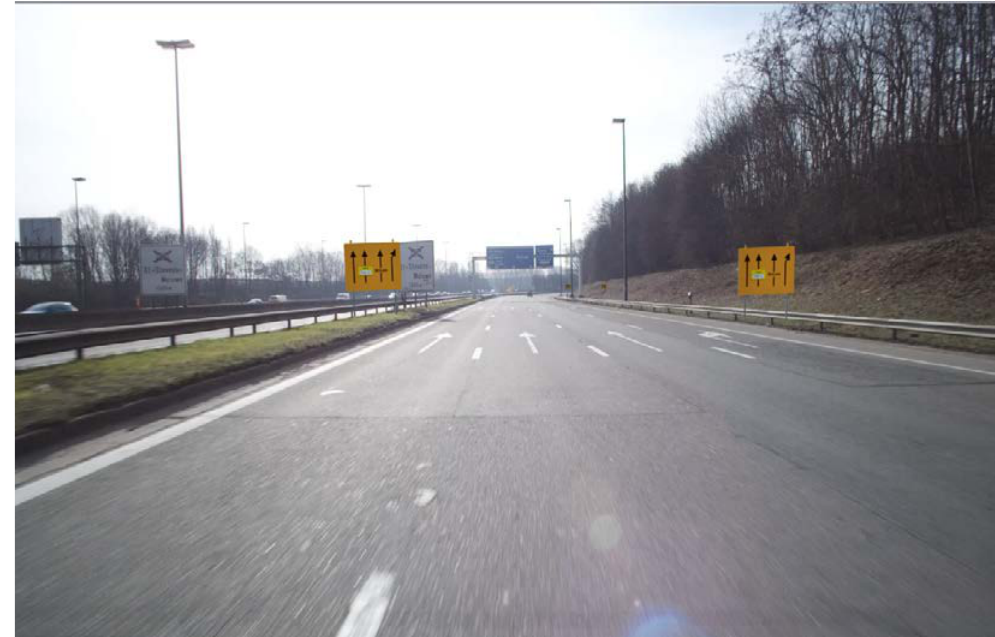
Figure 8. Interference between temporary and permanent traffic